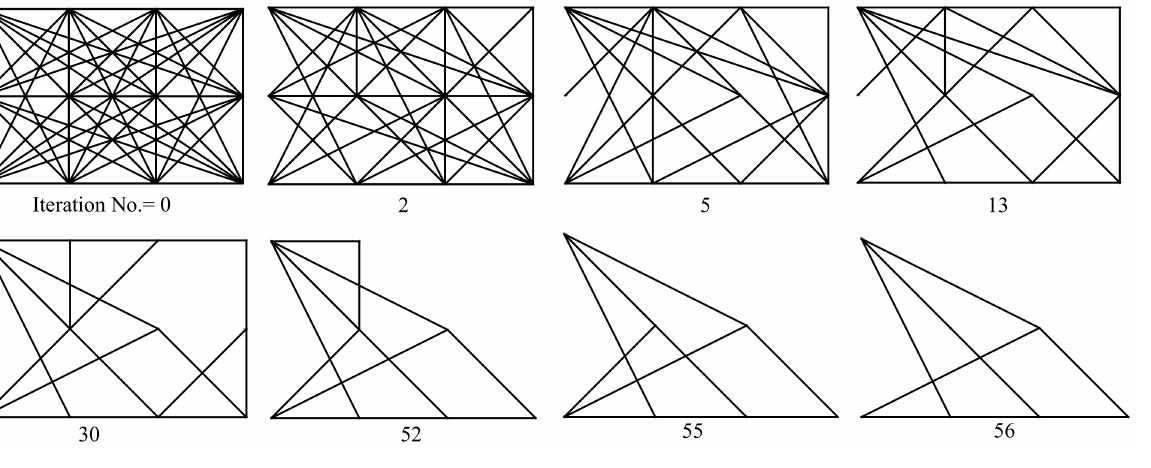
Figure 12. Topology evolution of the 63-bar truss.